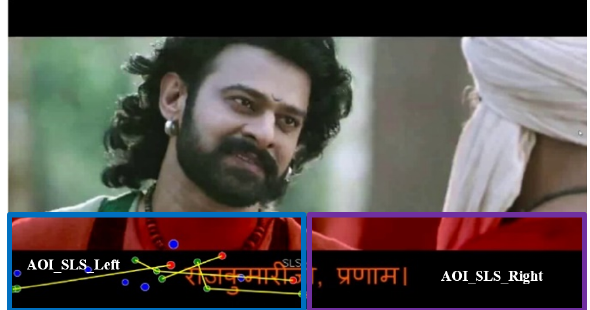
Figure 9: Fixations at AOI_SLS (left/right) of a poor reader